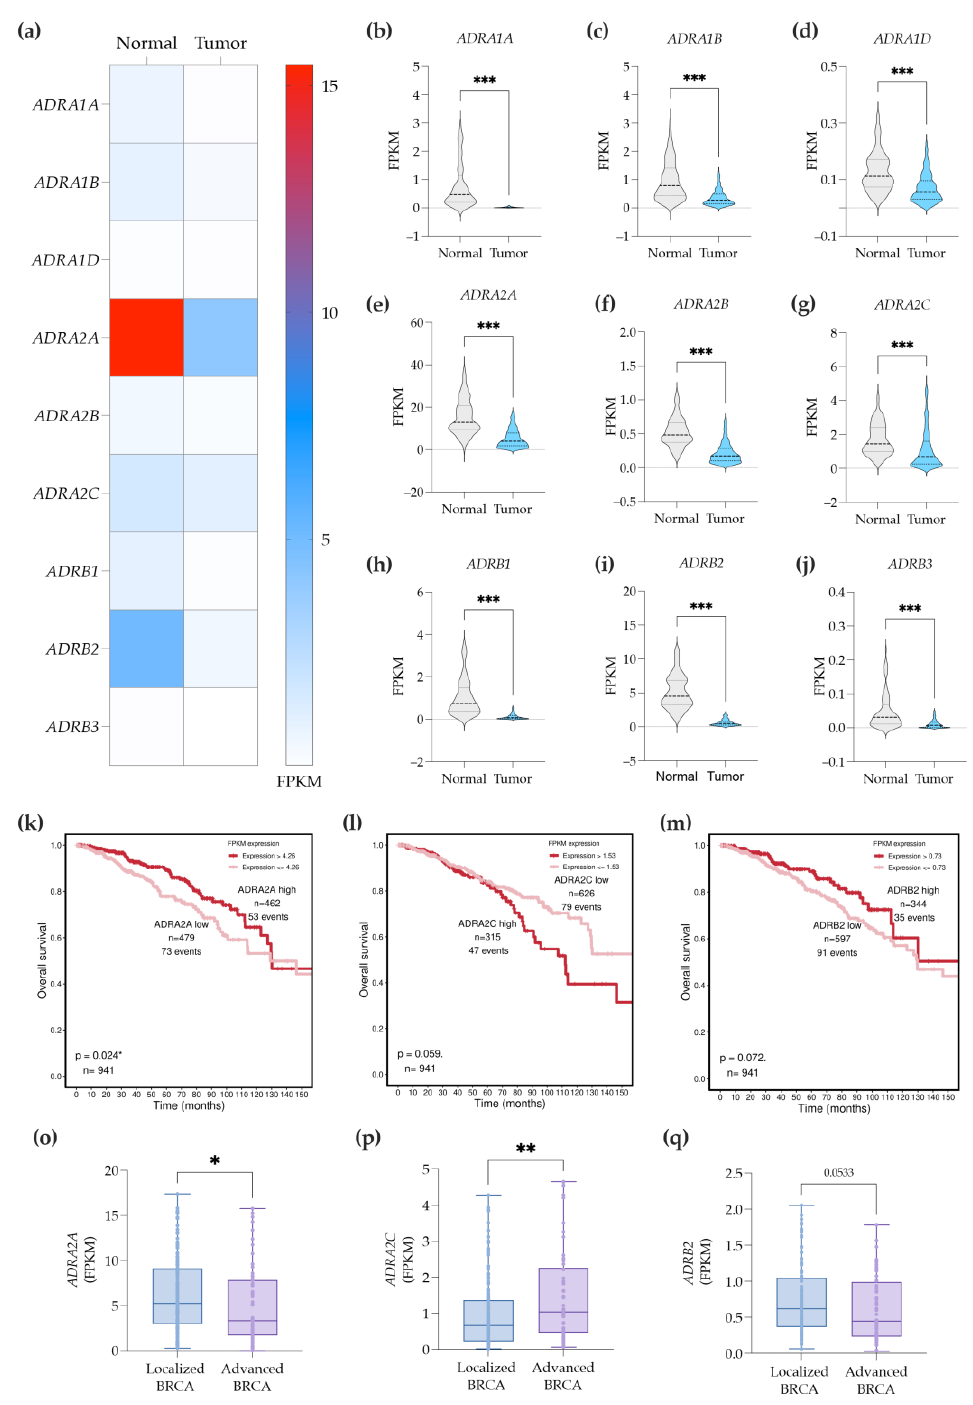
Figure 3. Gene expression profile of ADRs in BC tissues (using the BC dataset included in the TCGA database). ( a ) Heatmap of ADR expression in the TCGA-BC tissues versus their adjacent normal counterparts’ tissues. Charts comparing normal versus BC tissues for each ADR gene expression are illustrated in ( b – j ). The survival curves for ADRA2A ( k ), ADRA2C ( l ), and ADRB2 ( m ) are depicted. The tumor gene expression of ADRA2A ( o ), ADRA2C ( p ), and ADRB2 ( q ) in patients with localized and advanced BC is shown. p -value < 0.05 (*); <0.01 (**), <0.001 (***) was considered statistically significant.